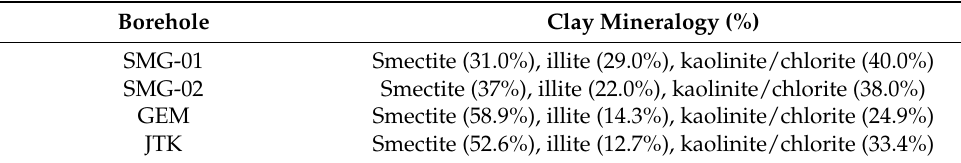
Figure 7. XRD diffractograms: ( a ) Semarang clay; ( b ) Demak clay. Table 1. Result of semi quantitative analysis of Semarang-Demak clay.